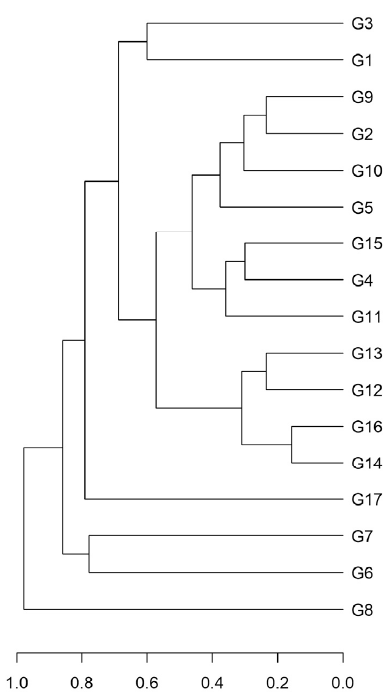
Figure 3. Dendrogram of the ‘Greco’ clones (G) based on the REMAP profile. The dendrogram